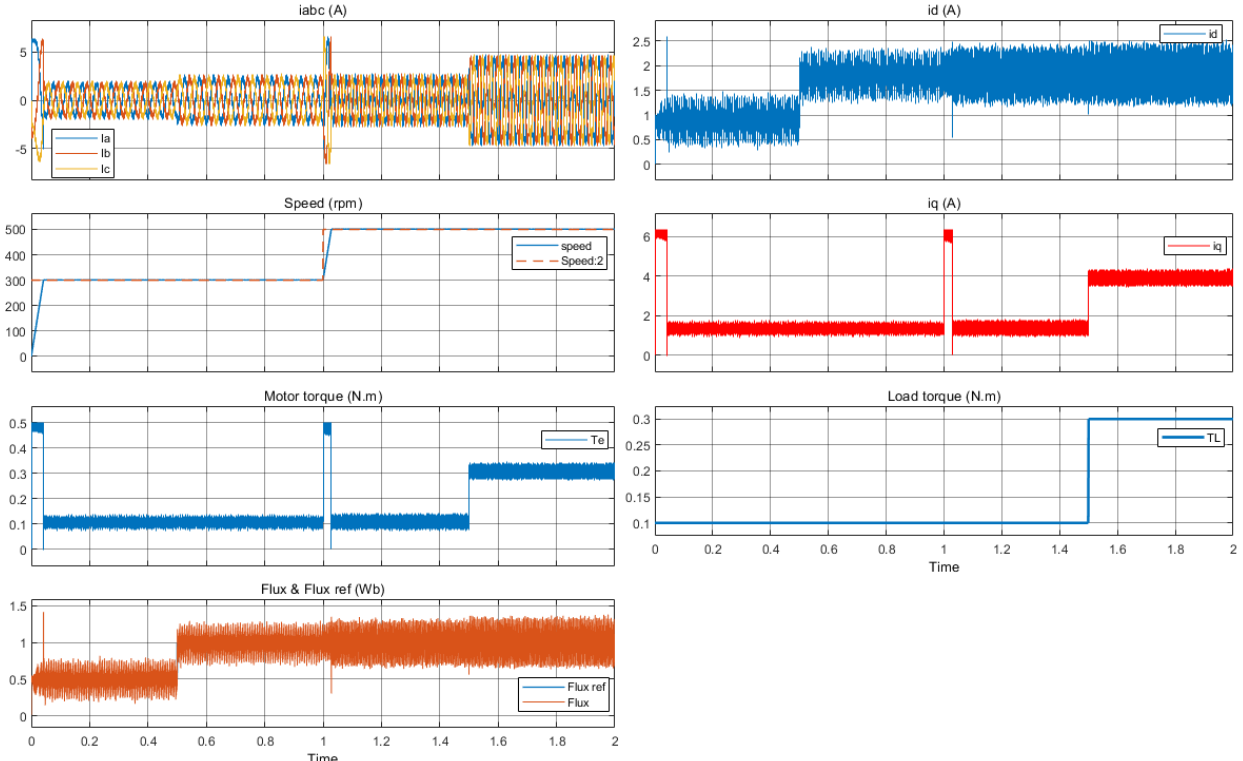
Figure 5. Simulation results of the overall performance of the